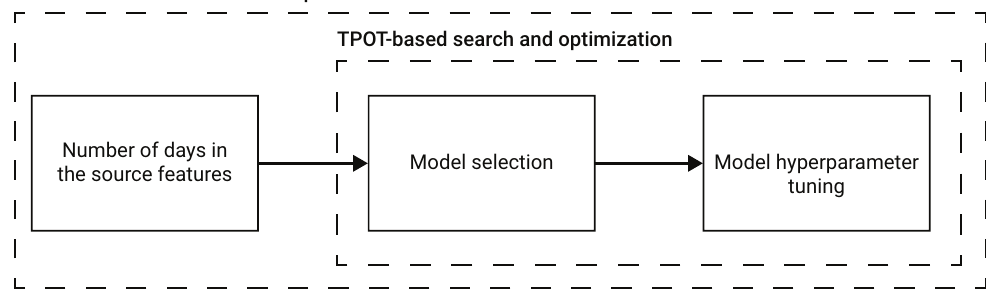
Figure 1. A schematic view of the auto-ML process to obtain the next wave prediction model. The number of days in the source features is picked using a grid search based approach, aiming to optimize the F 1 score of the obtained model. Based on the picked number of days in the source features, we utilize TPOT [27] to find an ensemble of ML regression models and their